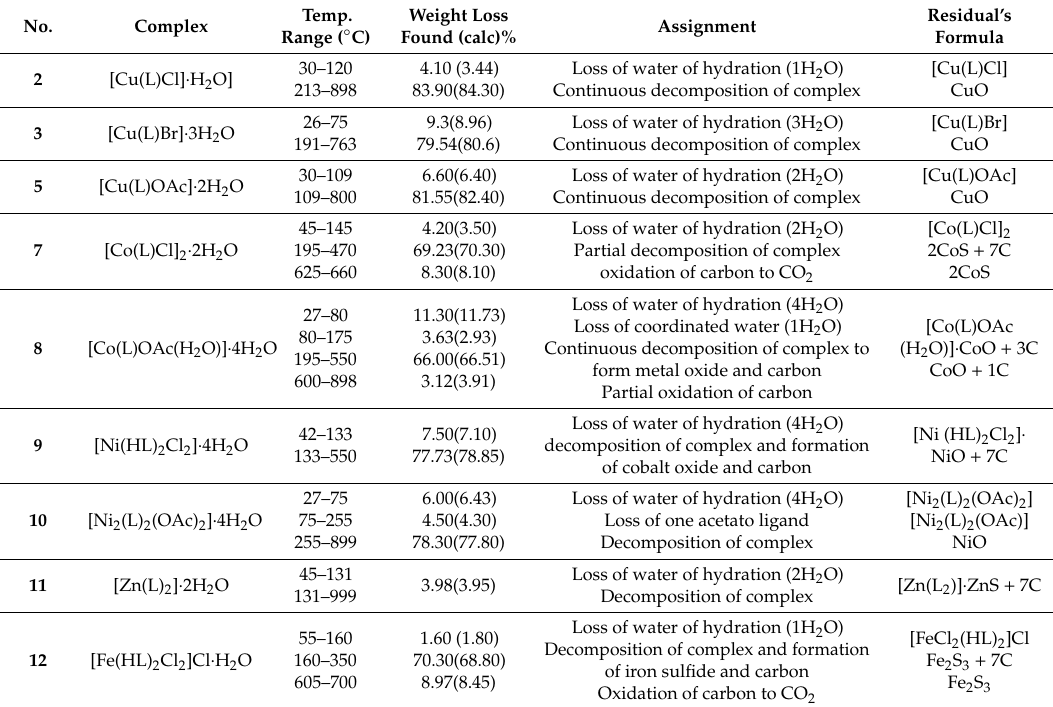
Table 5. Thermal (TGA) data for metal complexes 2 , 3 , 5 , and 7 – 12 .